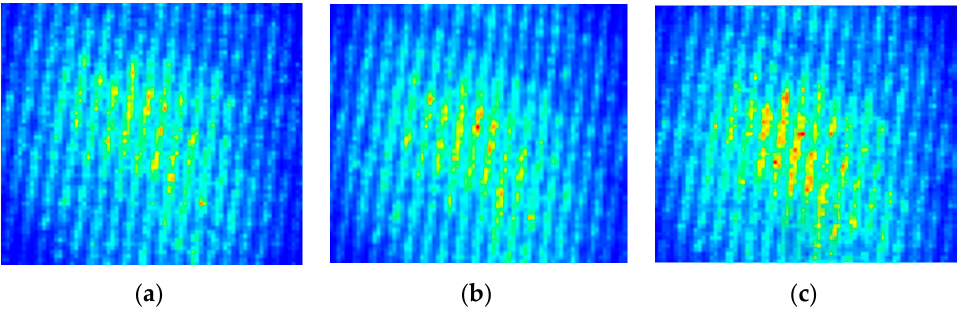
Figure 6. Images of interference fringes with 500 MHz communication each way. ( a ) Without algorithm; ( b ) with the SPGD algorithm; ( c ) with the AdaDelSPGD algorithm. algorithm; ( b ) with the SPGD algorithm; ( c ) with the AdaDelSPGD algorithm.